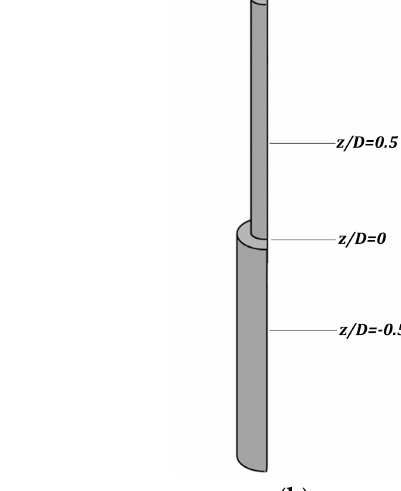
Figure 1. Cylinder configuration; ( a ) flow direction and coordinate description; and ( b ) measuring zones.